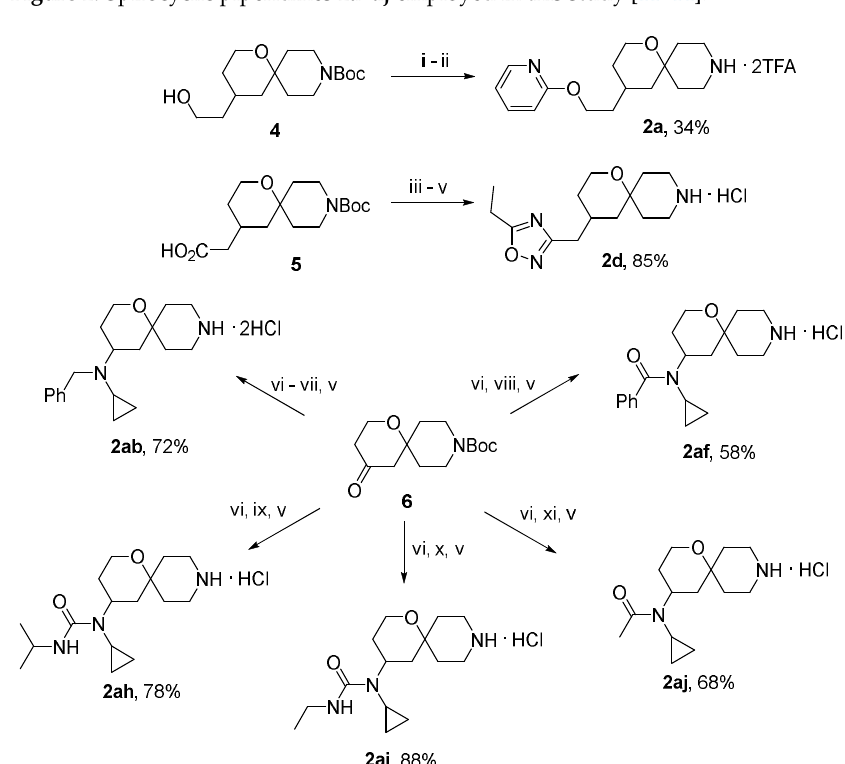
Figure 2. Spirocyclic piperidines 2a–aj employed in this study [11–14].